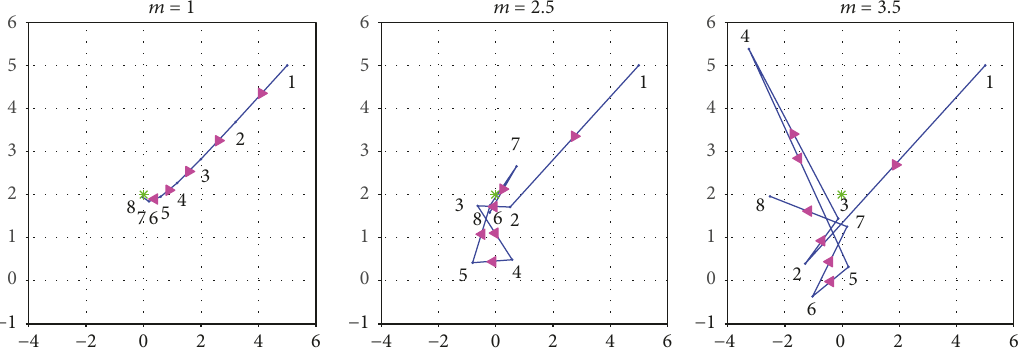
Figure 3: Three Newton paths with a di ff erent degree coe ffi cient m : they are initiated from the same point (5, 5). The guiding function is f z = z z − 2 i z + 1 − i .